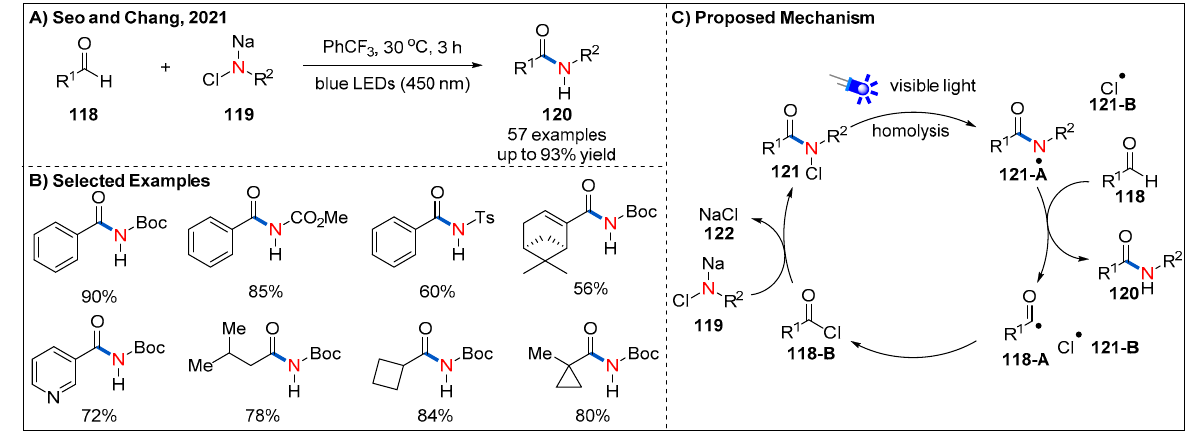
Figure 36. Visible-light-promoted N -chloro- N -sodio carbamate-mediated amidation of aldehydes.